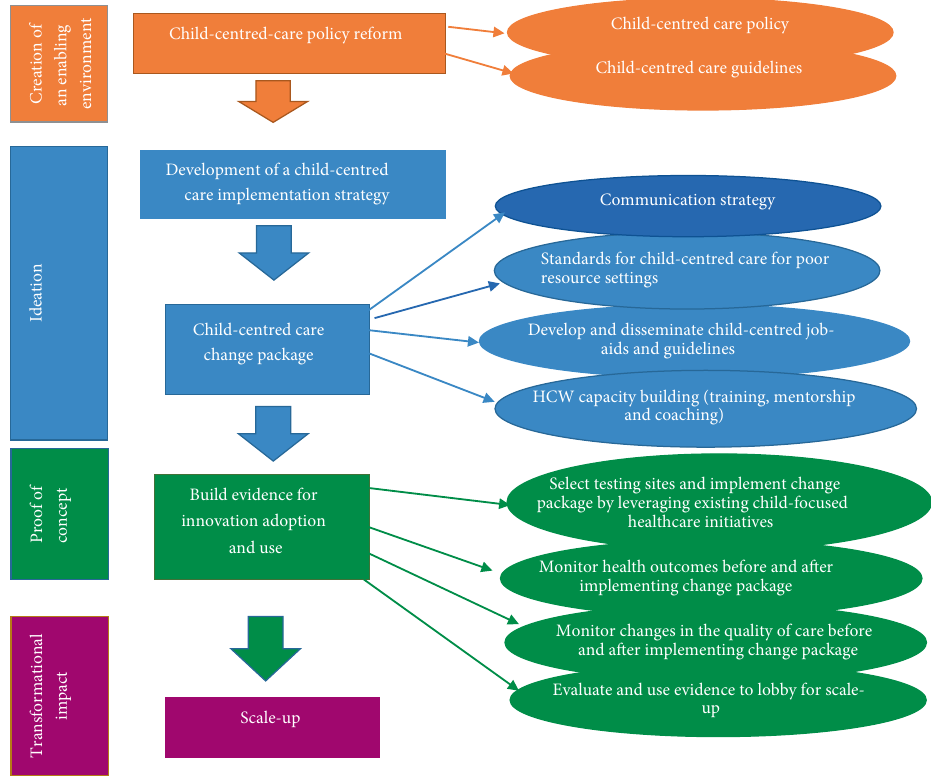
Figure 1: Proposed child-centred care implementation framework for resource constrained